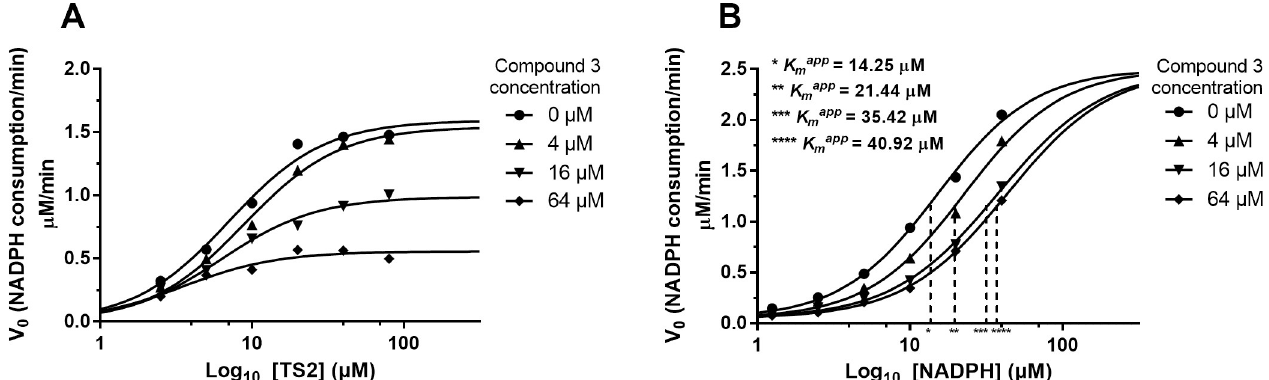
Fig 7. Compound 3 competition with either TS 2 or NADPH for the TR activity. Either TS 2 or NADPH were titrated alone or against three compound concentrations (4, 16 and 64 μ M). The NADPH concentration for the TS 2 dilutions (A) was 40 μ M while the TS 2 concentration for the NADPH dilutions (B) was 30 μ M. The TR assay was performed using 1 nM TR for 5 min. Each experimental point is the average of three replicates (error bars bigger than the symbol size were not